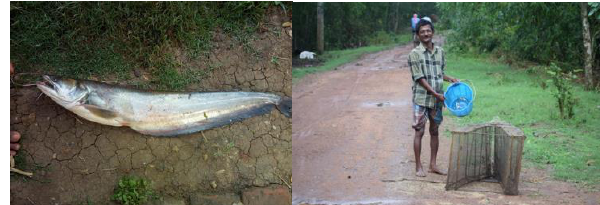
Figure 3: An experienced fisherman Ganesh Mandal 52 years old from Gopalur village caught this Attu fish using Morola fish as fishing baits by Tanga- the most perfect and usable traditional fishing method to cache this fish. The pictures were taken at the time of field visit in